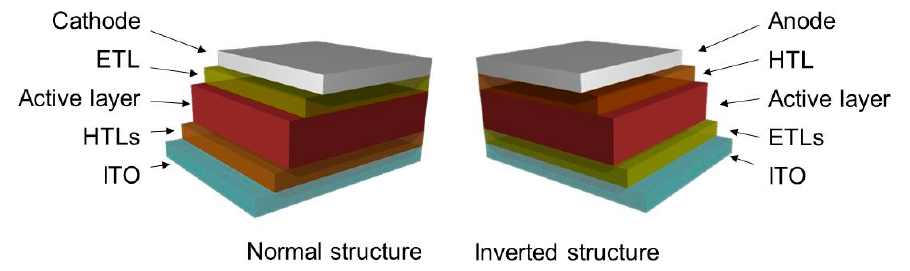
Figure 1. Structure of normal and inverted polymer solar cells (PSCs).